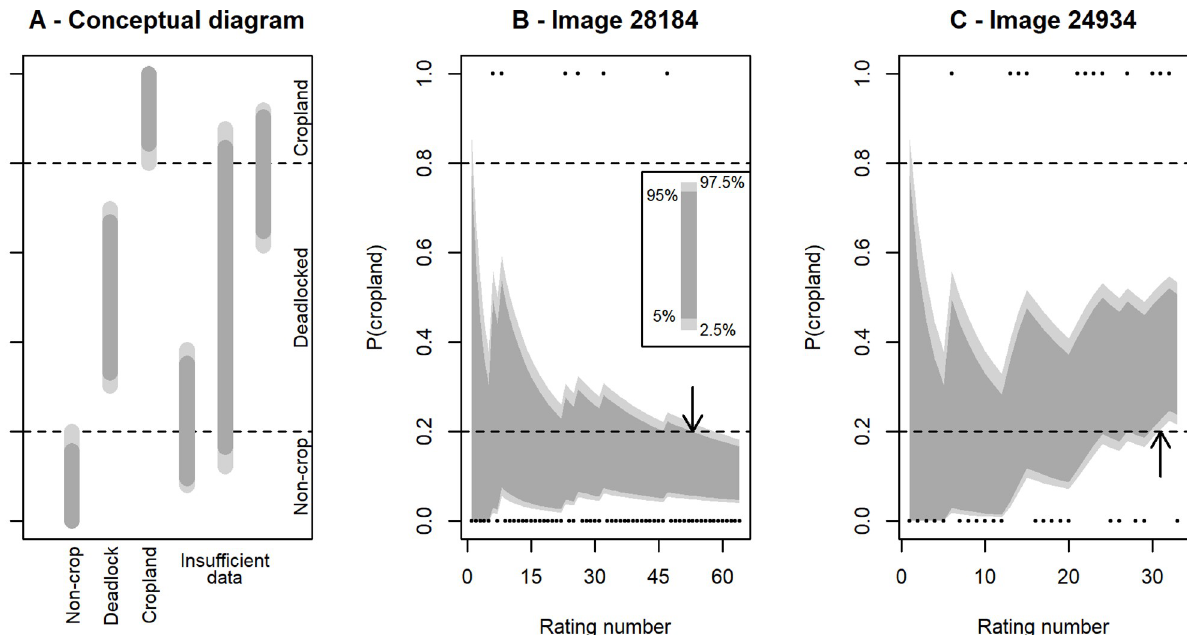
PLOS ONE | https://doi.org/10.1371/journal.pone.0267114 May 19,